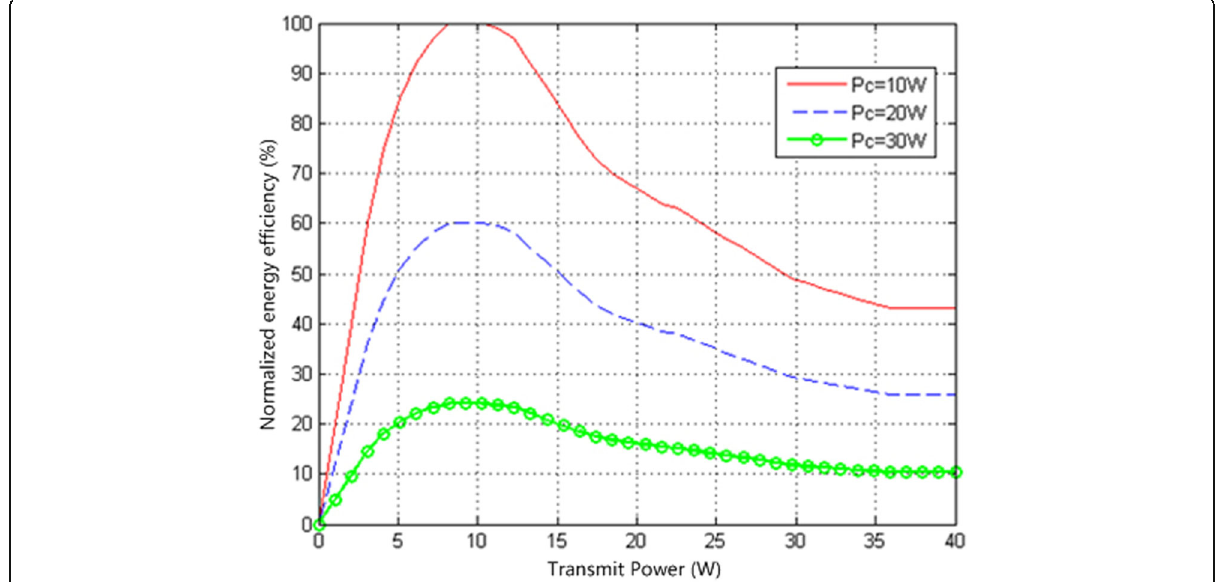
Fig. 2 System energy efficiency v.s. transmit power